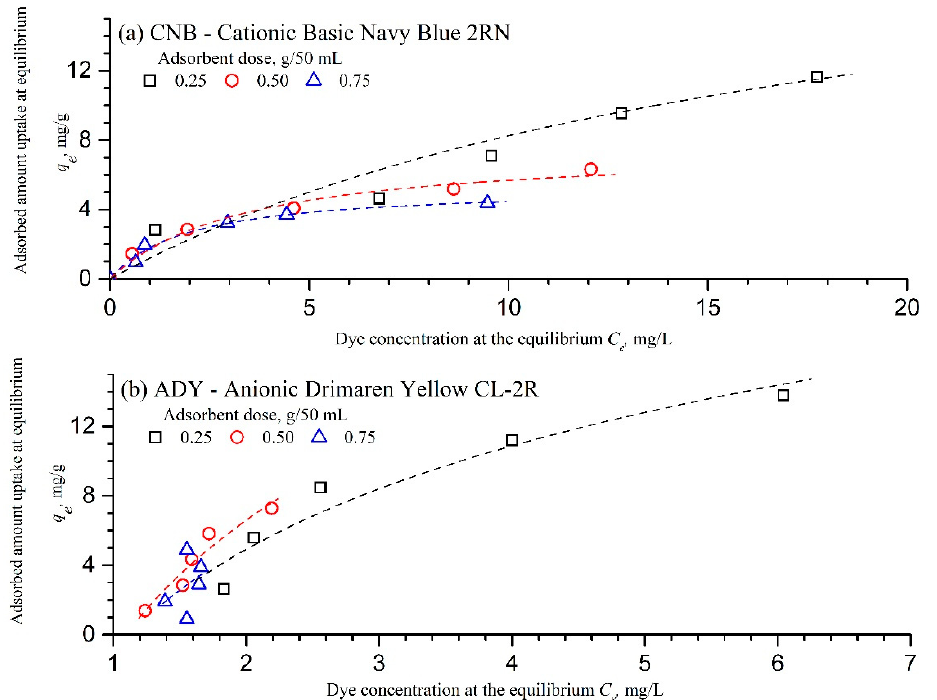
Figure 9. Adsorption data at equilibrium at different initial adsorbent dosages; each couple of q e and C e values lead to one point that results from an initial dye concentration C o of 15, 30, 45, 60, and 75 mg/L; T = 20 °C. ( a ) Adsorption data at equilibrium for the CNB. The dashed line represents the theoretical data predicted by the LM, Equation (4). ( b ) Adsorption data at equilibrium for the ADY. The dashed line represents the theoretical data predicted by the TM, Equation (7).